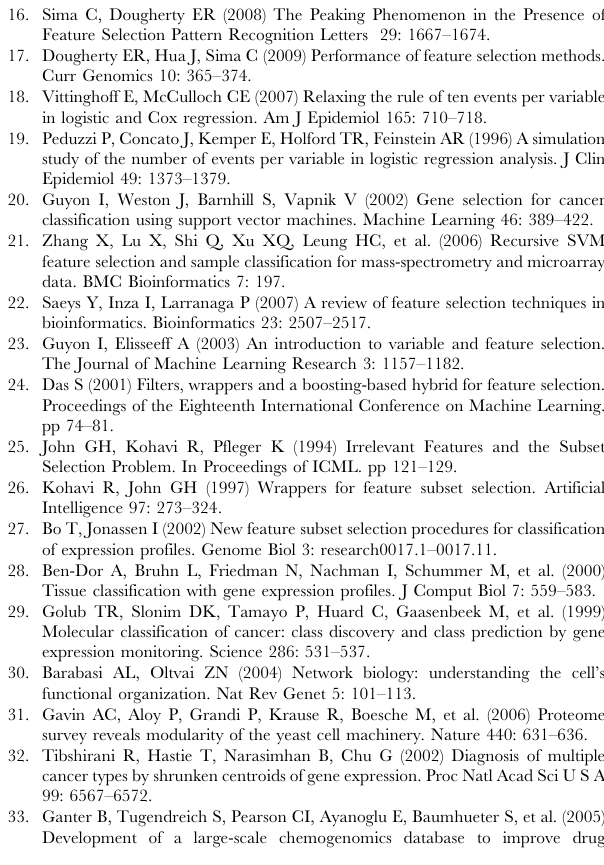
Table S2 The list of the top 20 ranked genes for BDH, Necrosis, and